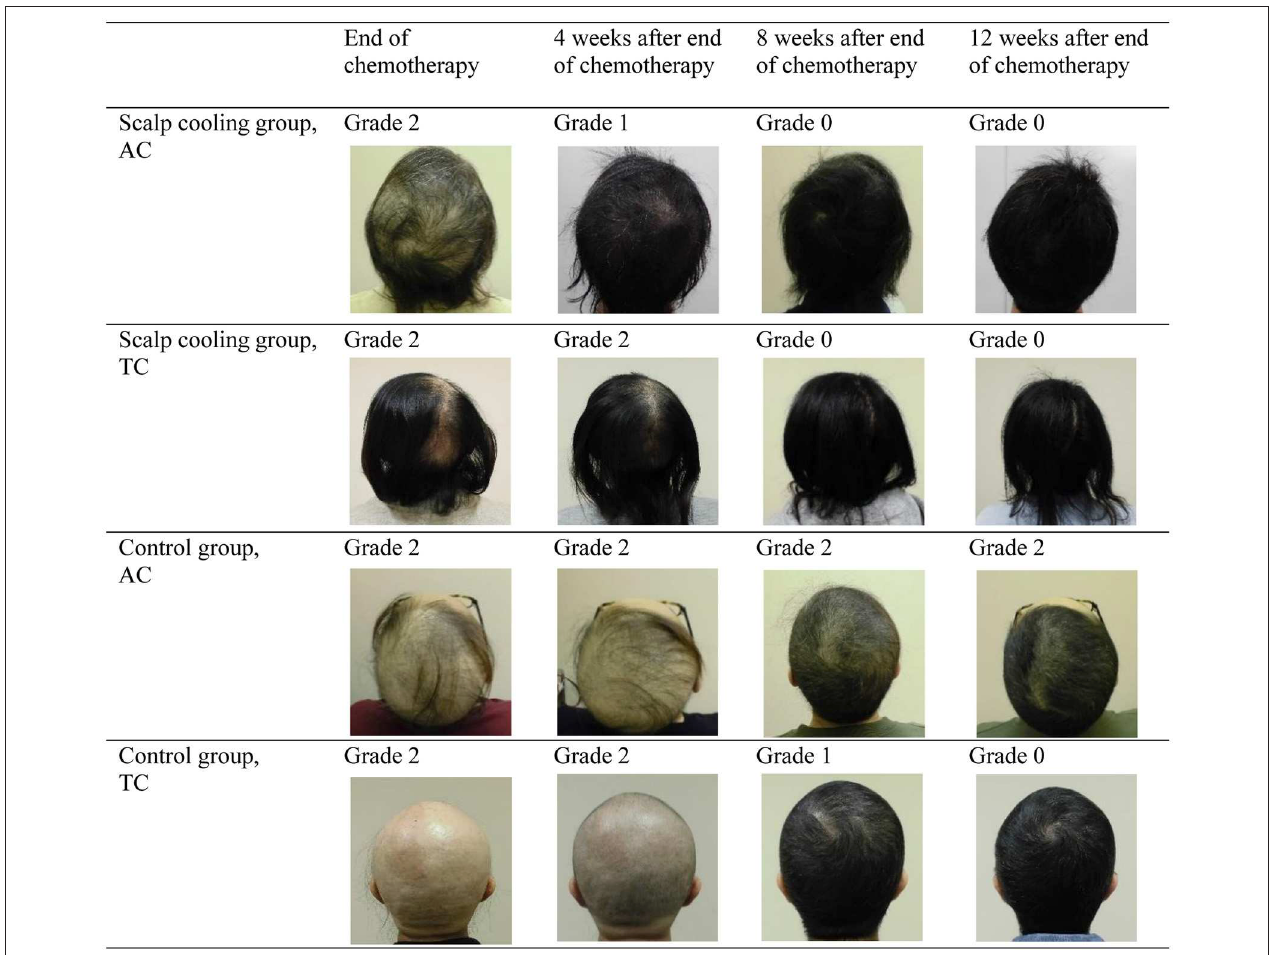
FIGURE 2 | Changes in hair loss following the end of chemotherapy (parietal views; grading by independent